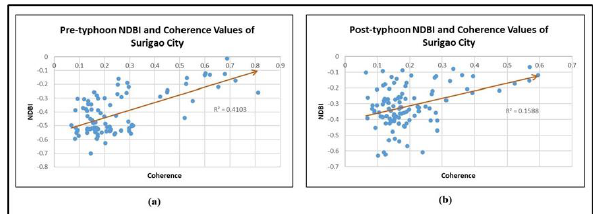
Figure 16 . Graph showing the relationship between NDBI and coherence values of Surigao City